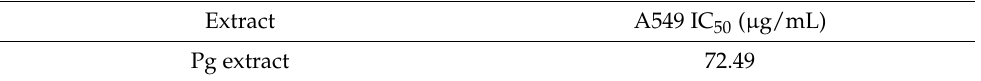
Figure 3. Pg extract ( a ) (10, 25 and 50) and ( b ) (75, 100, and 150 µg/mL) activity on A549 human lung adenocarcinoma cells’ migration and proliferation potential. Progression of cell migration was monitored by imaging the scratch line ini- tially and at 24 h post-stimulation. Images were taken by light microscopy at 10× magnification. Figure 4 represents the scratch closure rate for the selected concentrations. It can be noticed that Pg produced a decrease in the closure rate in a dose-dependent manner, in- dicating that the extract elicited an anti-migratory effect on A549 lung adenocarcinoma